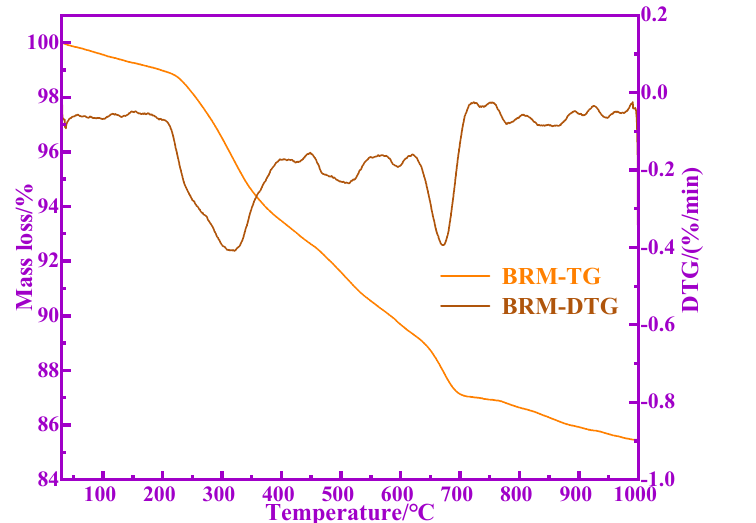
Figure 5. XRD patterns of BRM ( a ), CBRM ( b ), and Tailings ( c ). The TG-DTG curves of BRM are shown in Figure 6. Here, it can be seen that the con- tinuous mass loss of BRM occurs at 0–1000 °C and the mass loss rate is 14.63%. The mass loss rate in the range of 0–225 °C and 700–1000 °C is slower than that in the range of 225– 700 °C. The DTG curve shows that BRM mainly contains two obvious mass loss stages in